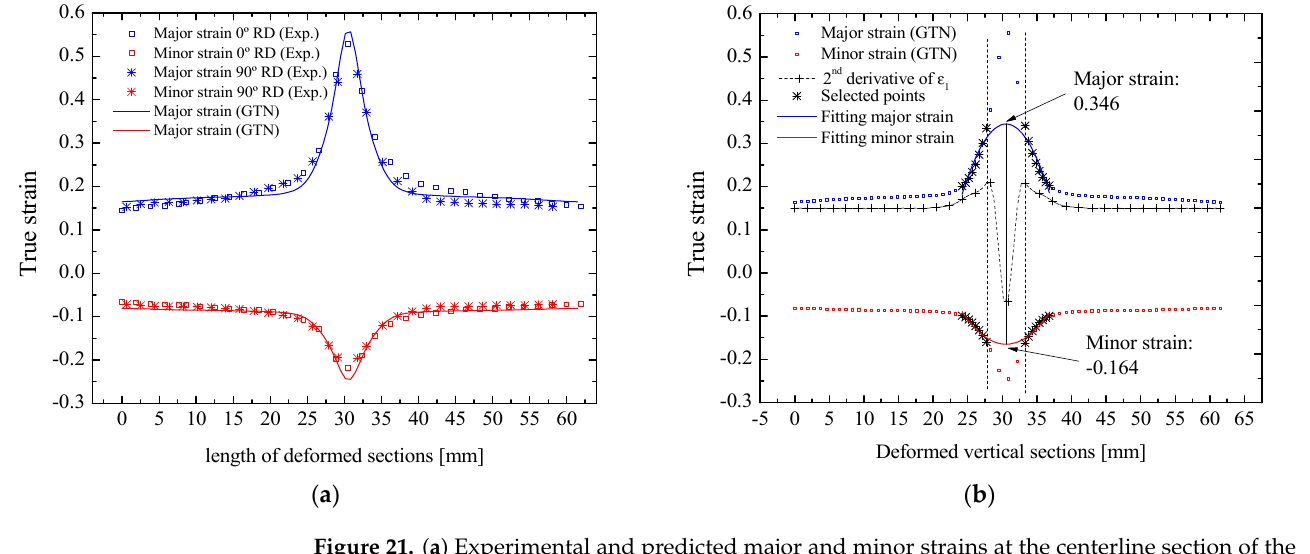
Figure 21. ( a ) Experimental and predicted major and minor strains at the centerline section of the uniaxial tensile specimen, and ( b ) limit strains from the uniaxial tensile test simulations using the GTN model.